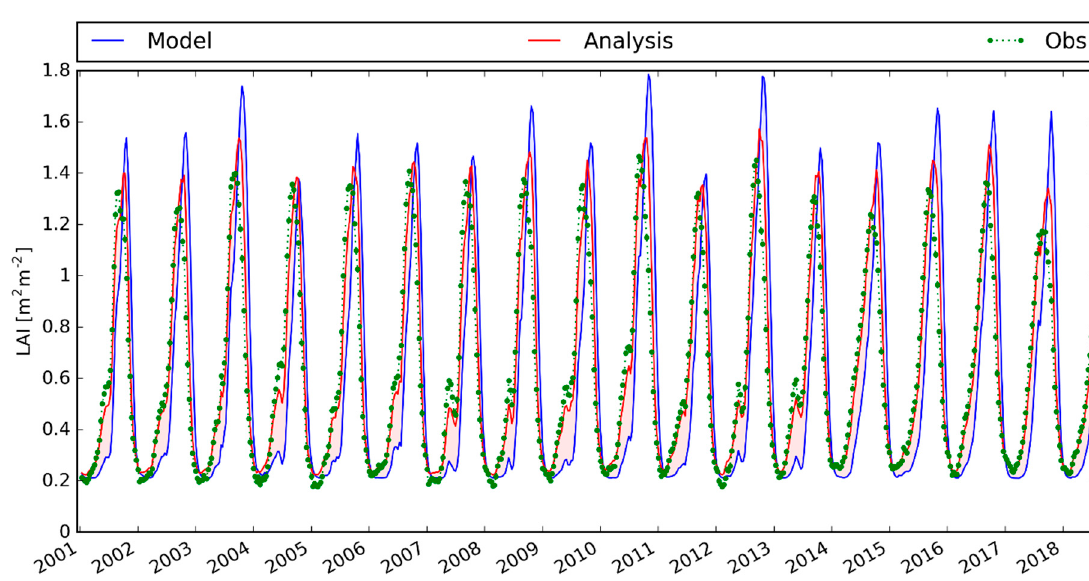
Figure 9. Monthly average values of LAI from 1 January 2001 to June 2018: model (blue line), satellite product (green circles), analysis (red line) in the LDAS-ERA5 configuration.